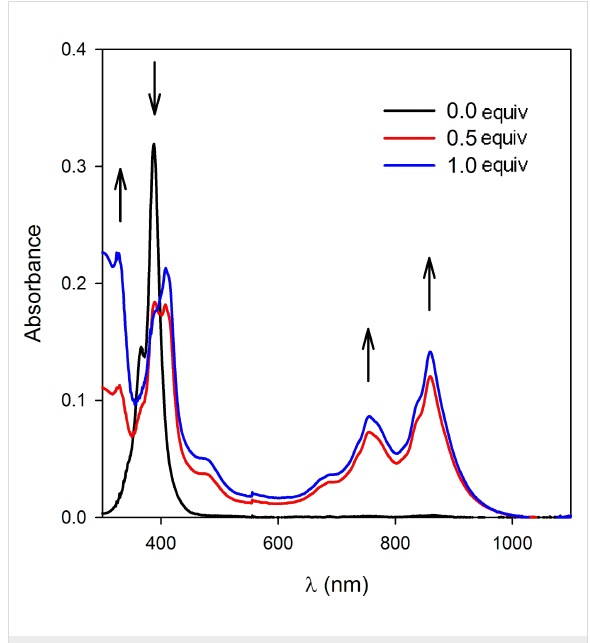
Figure 10: UV–visible absorption spectra of F 4 -TCNQ (CH 2 Cl 2 , 10 − 5 M) upon titration with molecular clip 3 (CH 2 Cl 2 , 5 × 10 − 4